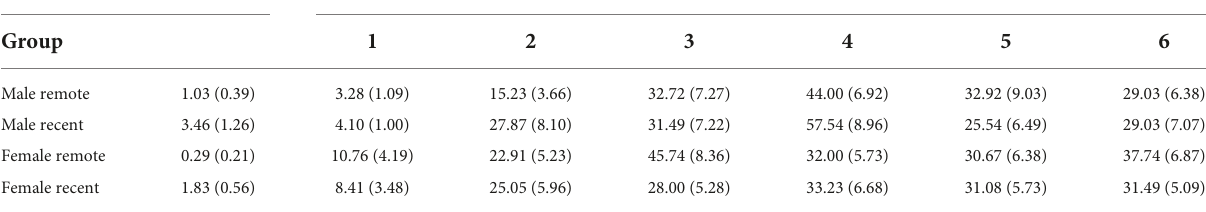
TABLE 1 Mean percent freezing ( ± SEM) during baseline periods for each group during conditioning and tone extinction/retrieval sessions. Conditioning Tone